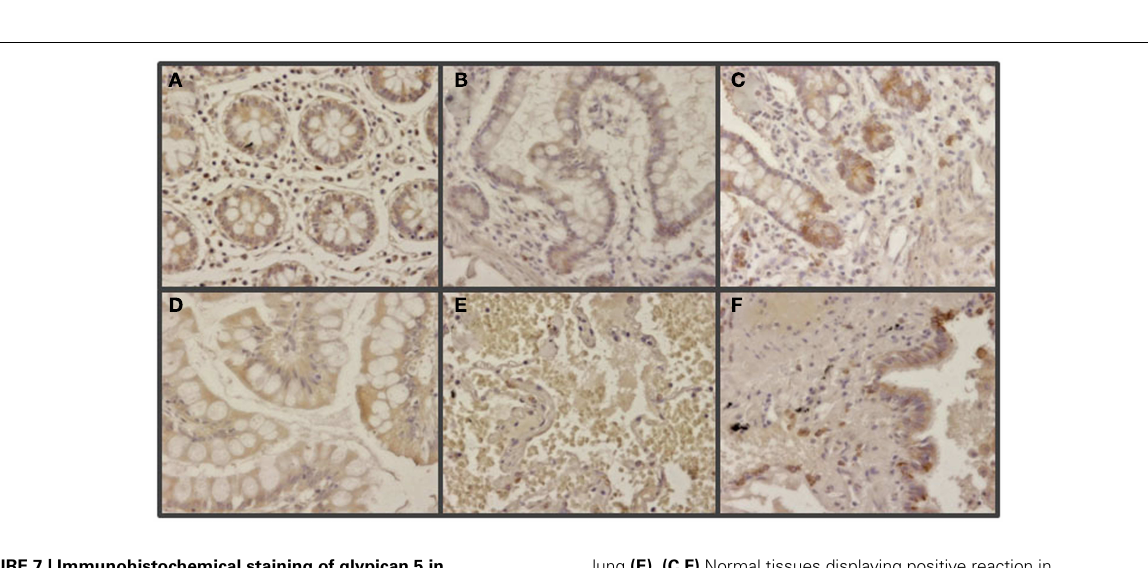
FIGURE 7 | Immunohistochemical staining of glypican 5 in normal tissues . (A,B,D,E) Normal tissues not expressing GPC5 from colon (A) , small intestine (B) , gastric transitional mucosa (D) , and